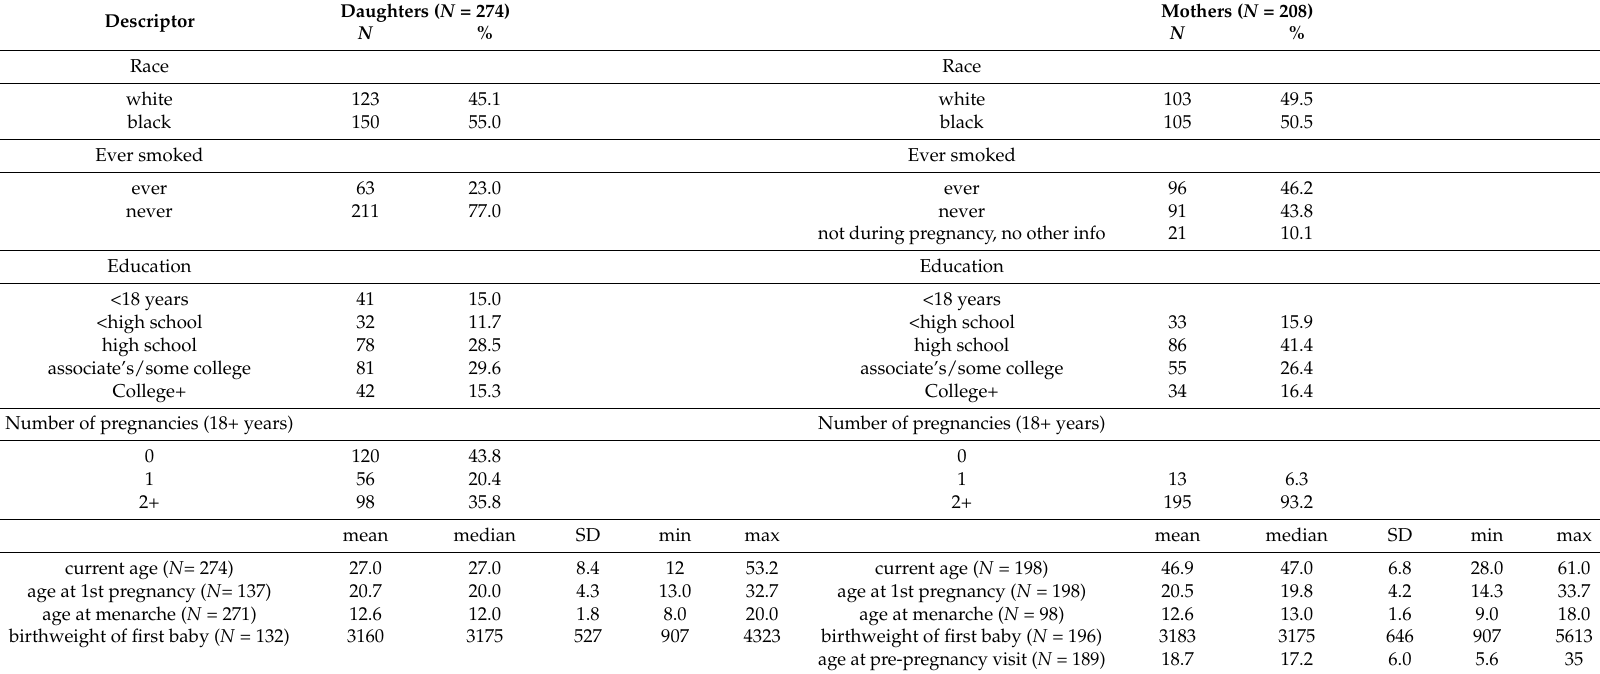
Table 1. Descriptive data, pilot study of daughters of Bogalusa Heart Study